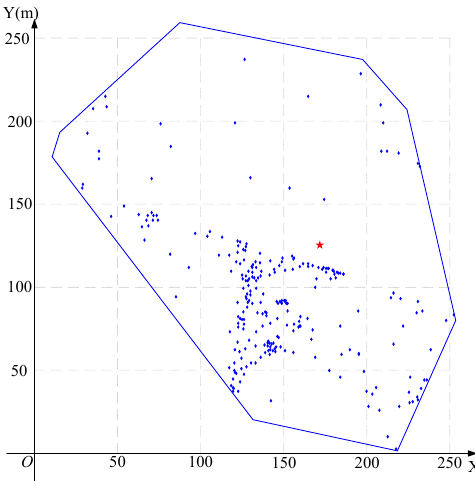
Figure 10. Center points of all pieces for the 20 -node